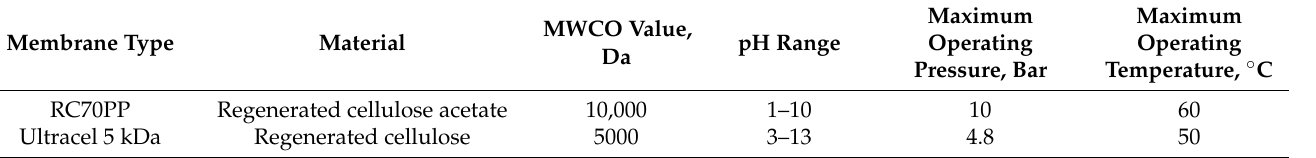
Table 1. Technical characteristics of the RC70PP membrane (Alfa Laval company) and the Ultracel UF Discs 5 kDa (Millipore